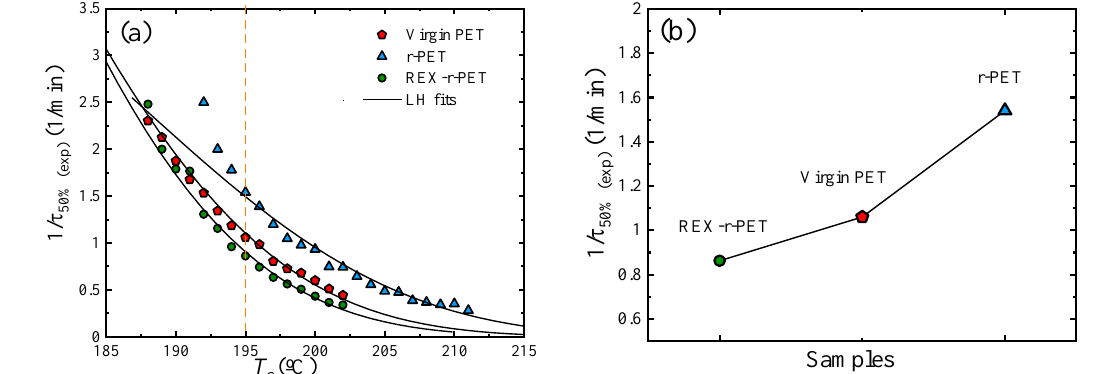
Figure 5. ( a ) Overall crystallization rate ( 1/t 50% ) as a function of the crystallization temperature T c . The solid lines represent fits to the Lauritzen and Hoffman theory. ( b ) Crystallization temperature values for the samples at a constant crystallization temperature of 195 °C.